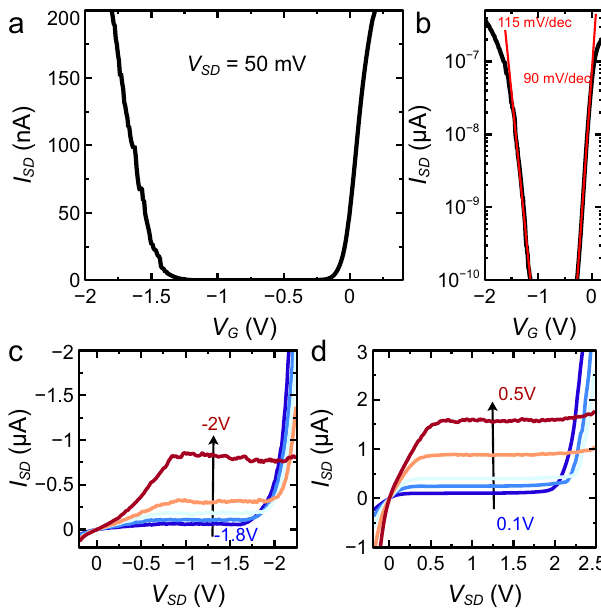
Fig. 2 Transistor characteristics of a 2L-WS 2 /4L InSe device. a Room- temperature transfer curve ( I SD -vs.- V G at fi xed V SD = 50 mV) of a 2L-WS 2 / 4L-Inse. b The high device quality is evidenced by the low subthreshold swings for electron and hole transport, whose values (115 mV/decade and 90 mV/decade, respectively, for this speci fi c transistor) are close to the ultimate limit of 60 mV/decade. c and d Output characteristics ( I SD as function of V SD ) of the same device for different negative and positive gate biases, respectively. Linear, saturation, and ambipolar injection regimes can be clearly identi fi ed upon increasing the magnitude of V SD , as described in the main text (see also Supplementary section